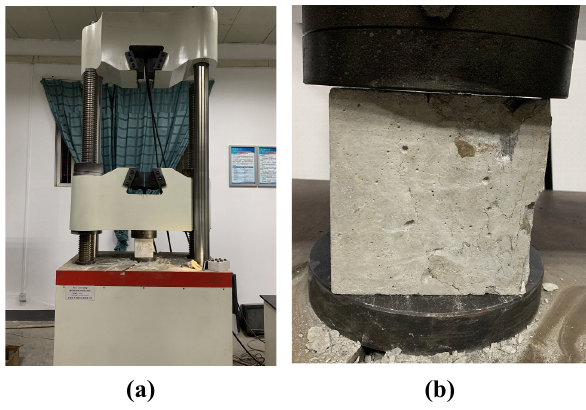
Figure 4: Cube compression test: ( a ) test device and ( b ) test process.